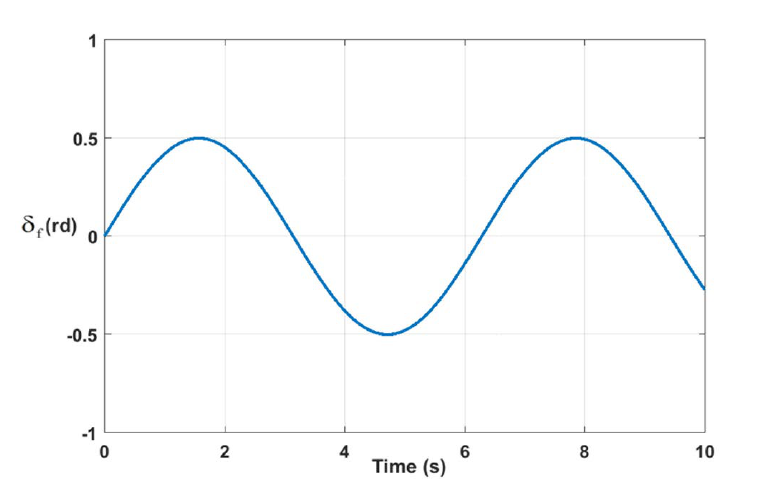
Figure 5. Longitudinal velocity of the vehicle.